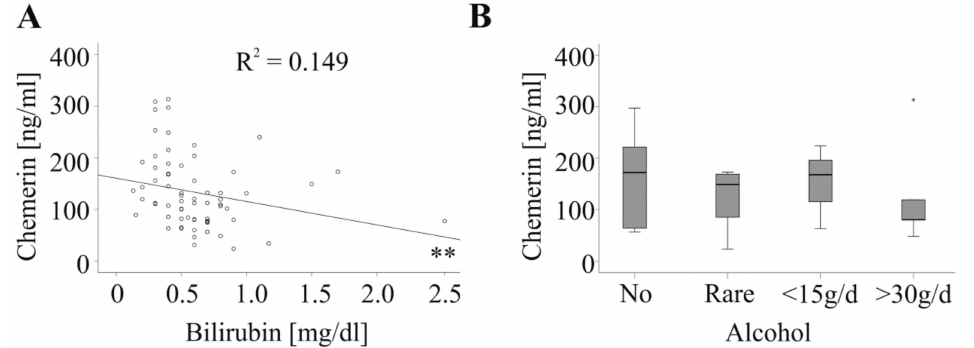
Figure 4. Serum chemerin, bilirubin and alcohol. ( A ) Correlation of chemerin with bilirubin in 31 HCC and 35 CRC patients. ( B ) Chemerin in HCC patients stratified for alcohol intake (No alcohol: 11 patients; Rare: 5 patients; < 15 g / d: 3 patients; > 30 g / d 5 patients). ** p <